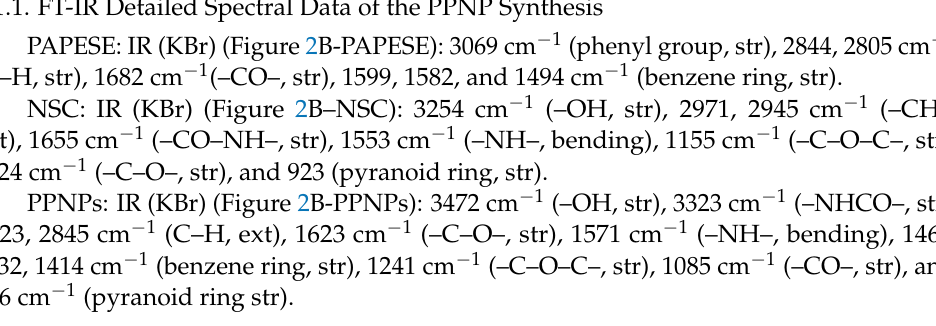
Figure 2. Chemical structures ( A ) and FT-IR characterizations ( B ) of evaluated treatments, the polymeric photoresponse nanoparticles (PPNPs), and their precursors, azobenzene derivate (PAPESE), and N-succinyl chitosan (NSC). TEM image ( C ), hydrodynamic particle size distribution in distilled water ( D ), and Z-potential graphic ( E ) of PPNPs.